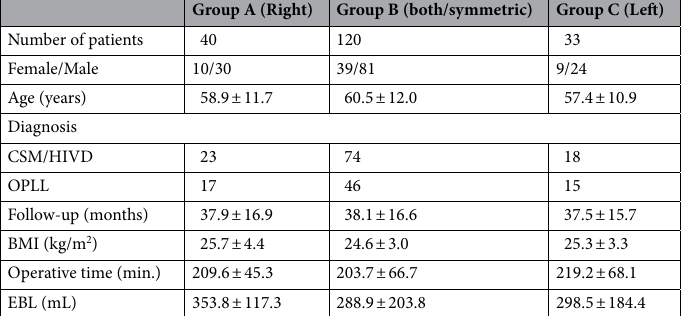
Table 1. Patient characteristics based on dominant compressive side. CSM indicated cervical spondylotic myelopathy; HIVD herniated intervertebral disc; OPLL ossification of posterior longitudinal ligament; BMI body mass index; EBL estimated blood